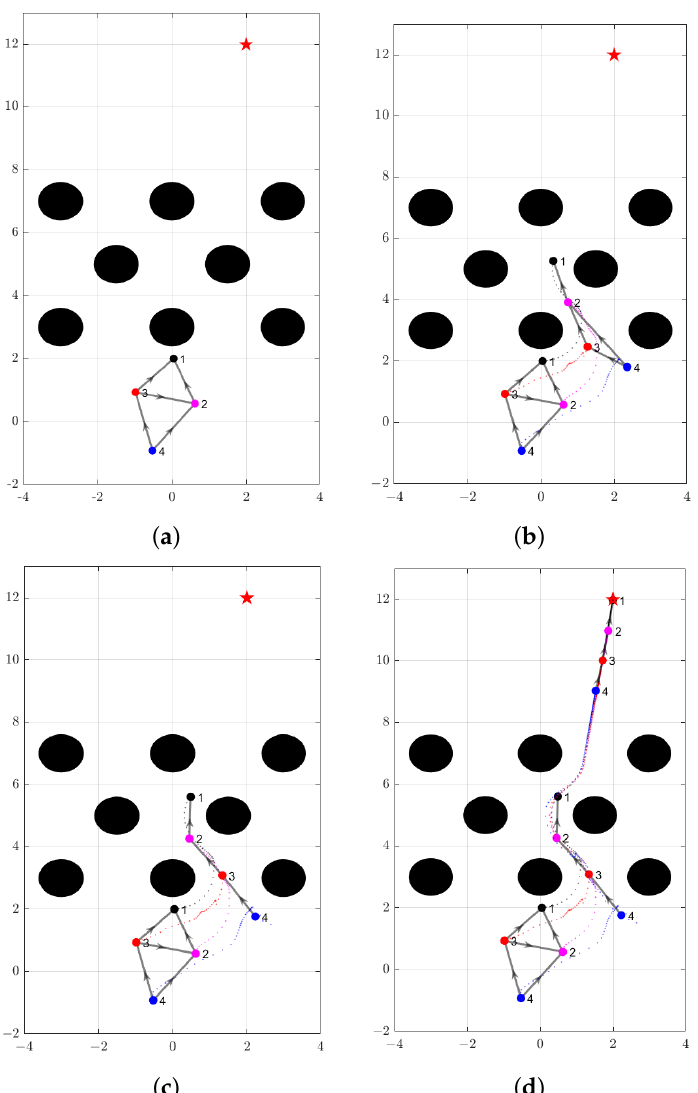
Figure 10. Four robots navigate in a known environment with dense obstacles. Solid black circles denote obstacles with radius r = 0.6 m. Four small colored circles represent robots. The sensing topologies at t = 0,0.7,0.76, and 6 s are plotted. ( a ) t = 0 s, ( b ) t = 0.7 s, ( c ) t = 0.76 s, and ( d ) t = 6 s.